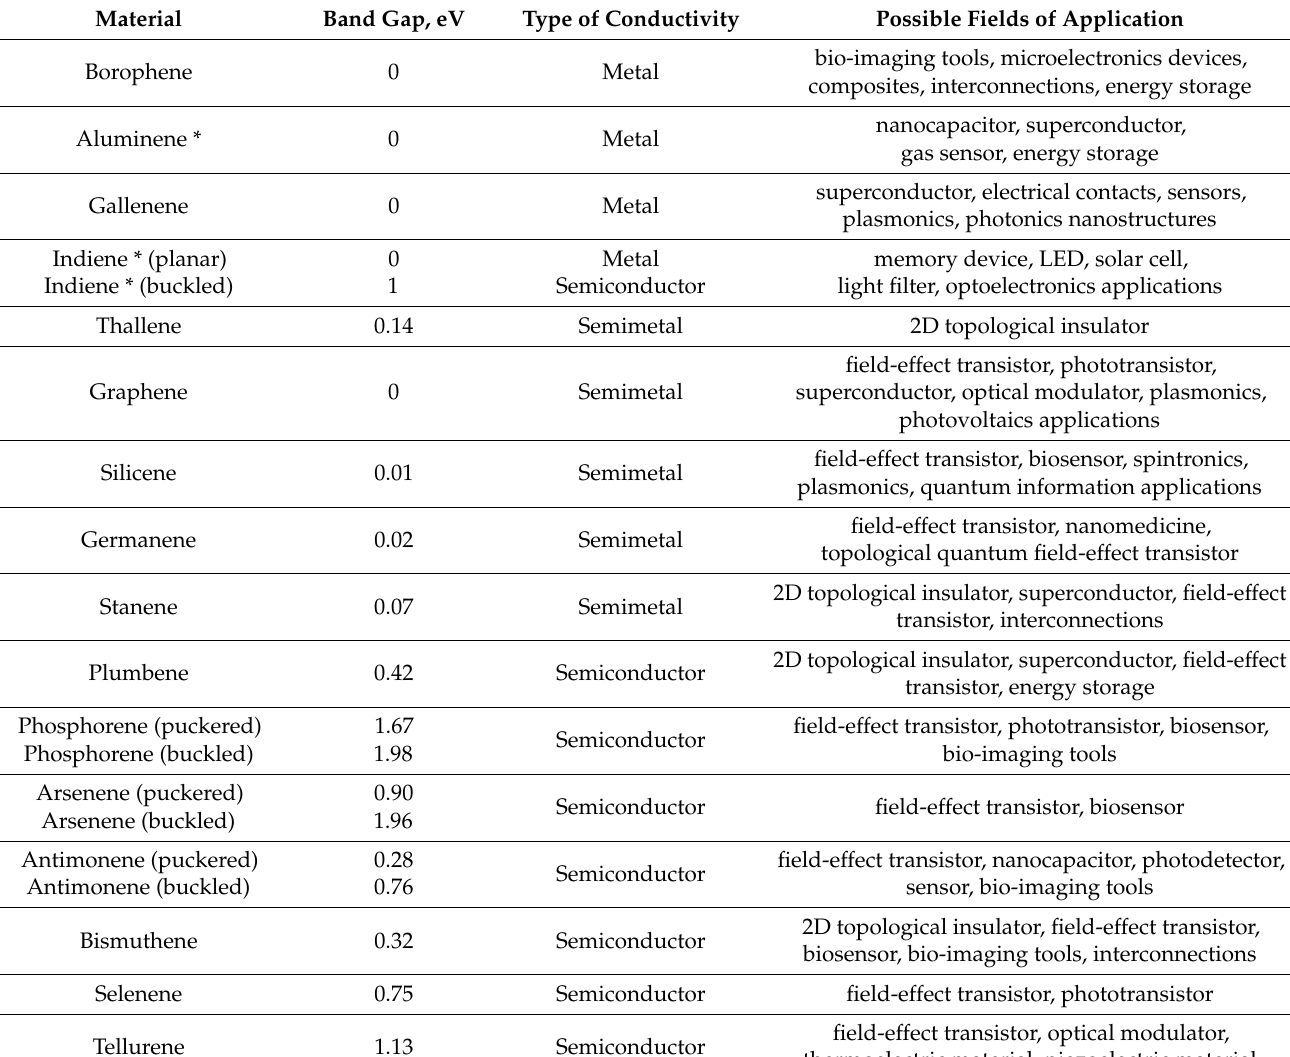
Table 5. Physical properties and application fields of transgraphenes (materials predicted only theoretically and not obtained experimentally are marked with *